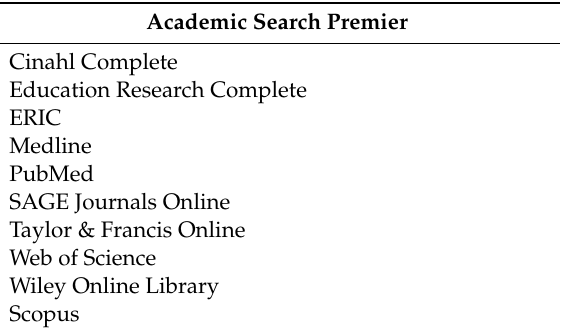
Table 1. Databases for search of papers.